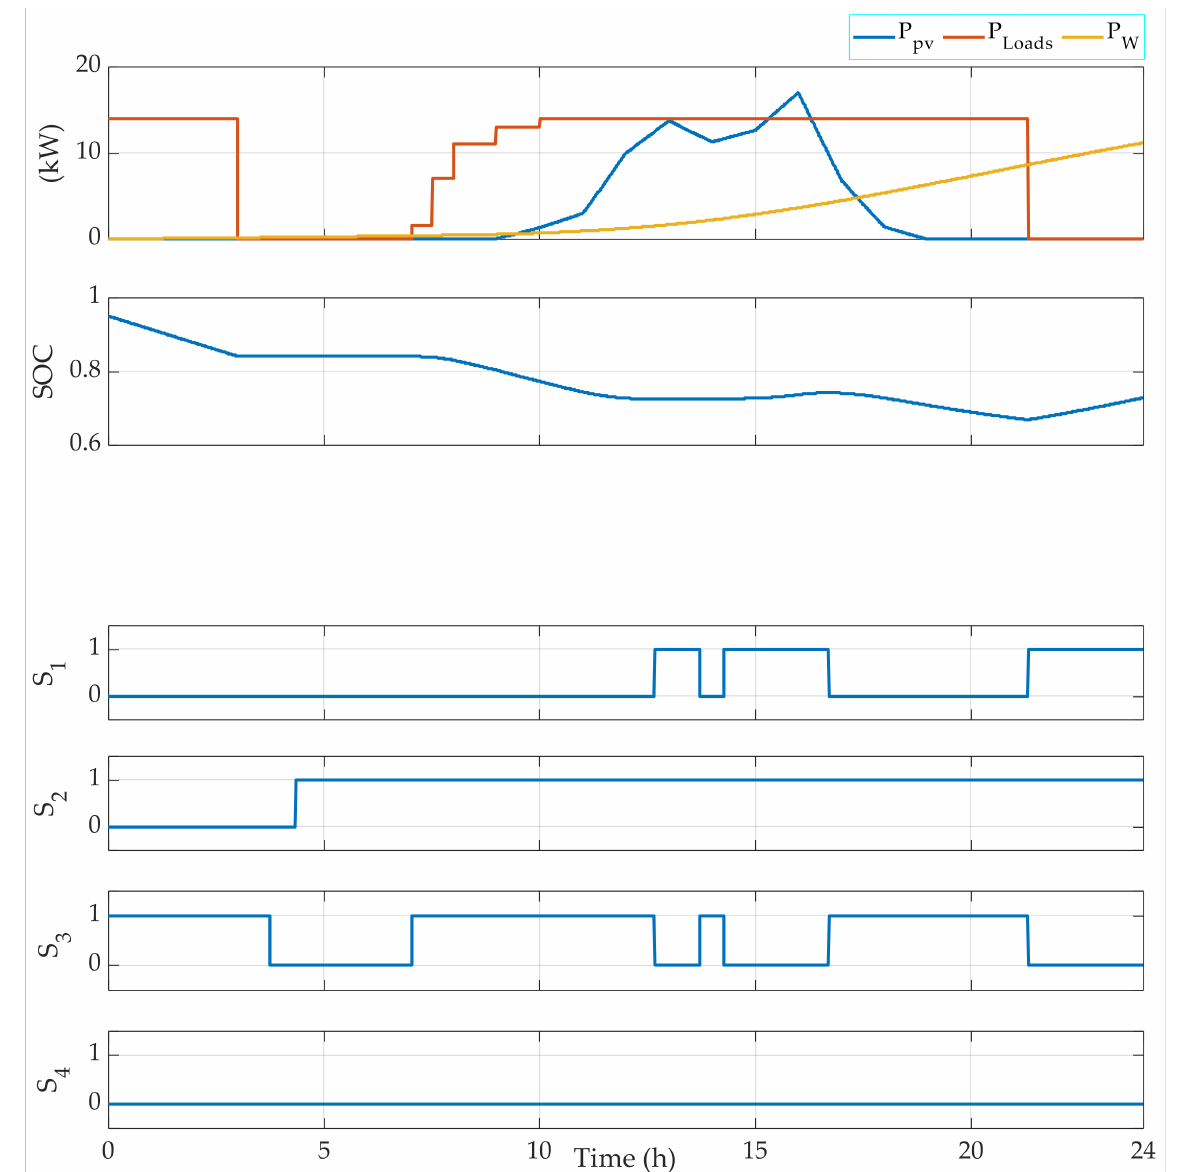
Figure 9. EMS results for the photovoltaic system in December using a variable loads power using an initially fully charged battery